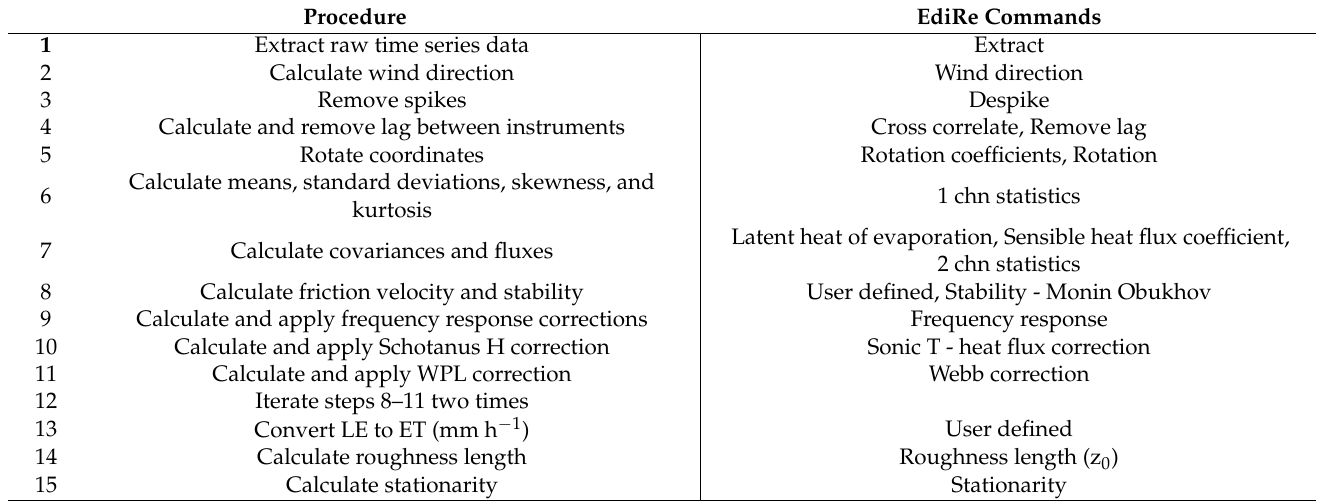
Table 2. Post-processing procedure using the software package